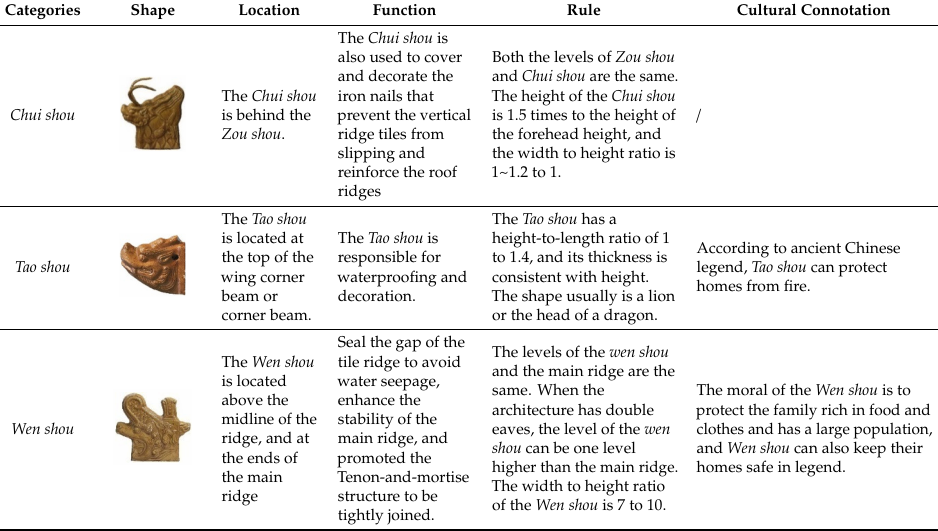
Table 3. The main roof decorative components of the Ming and Qing o ffi cial-style